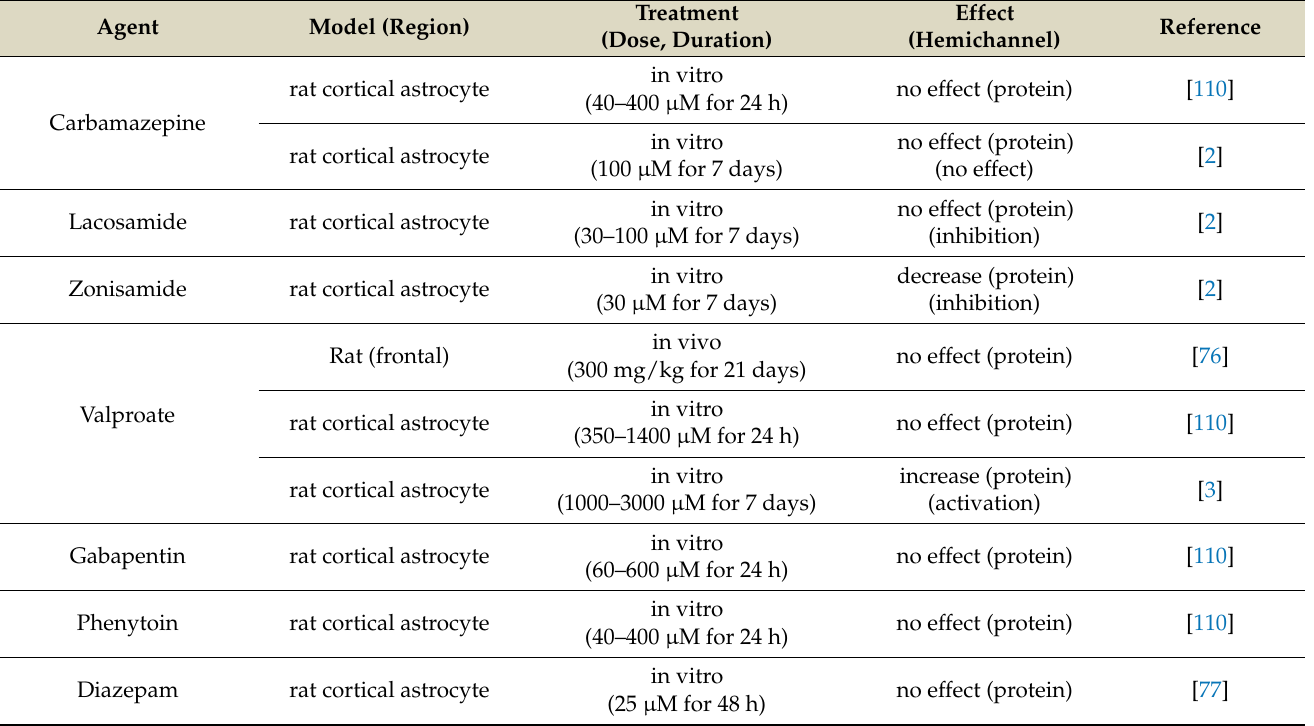
Table 5. Summary of the effects of first-line mood stabilisers and other anticonvulsants on the expression and function of Cx43.